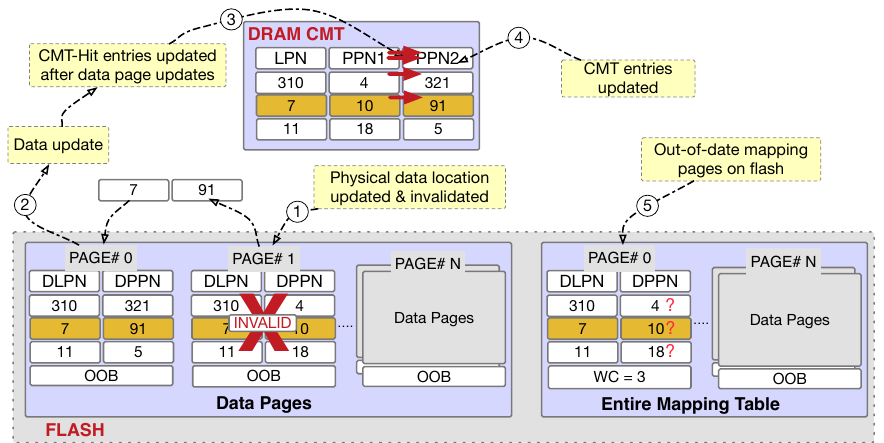
Figure 2. The drawbacks of traditional flash memory solid state drive (FSSD) booting schemes. MLPN/MPPN and DLPN/DPPN refers to the Mapping Pages Logical and Physical Page Numbers and Data Pages Logical and Physical Page Numbers